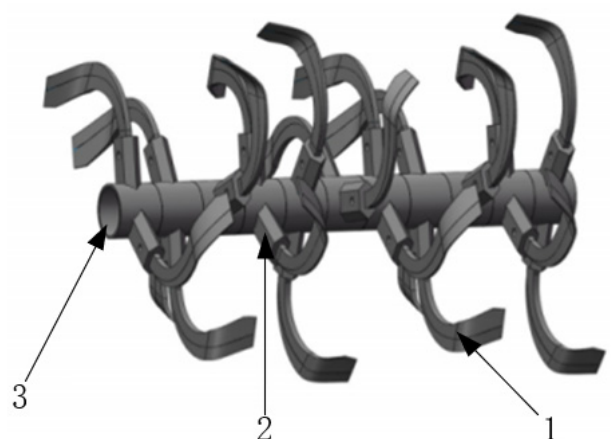
Figure 2. Structure of rotary tiller roller 3D model. 1. roller; 2. knife seat; 3. rotary tillage single knife.